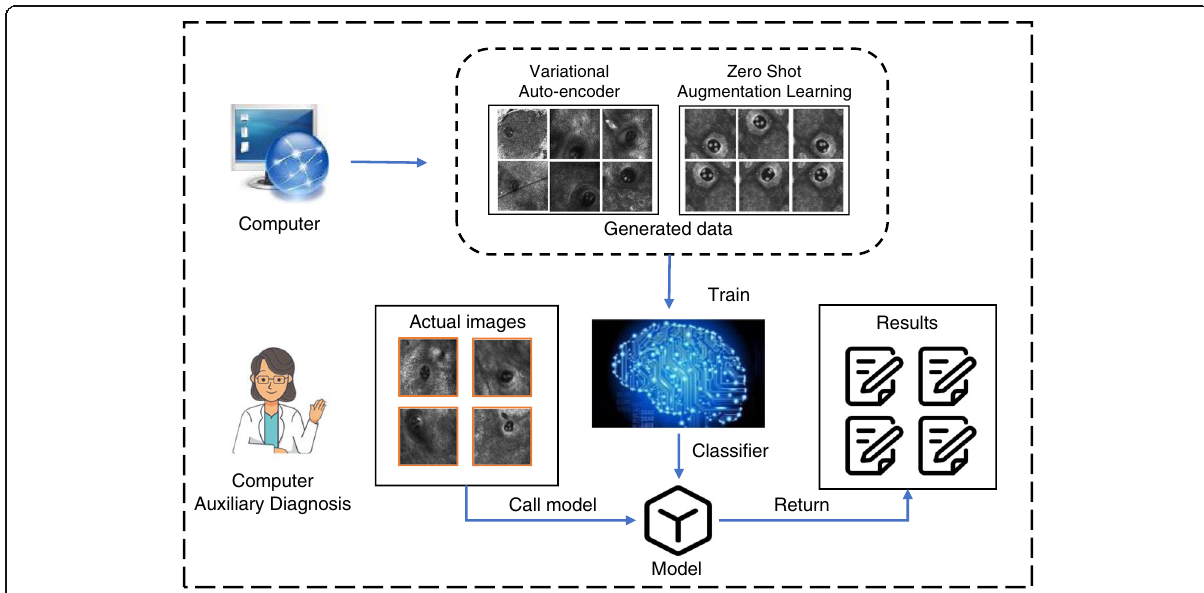
Fig. 3 Auxiliary diagnosis model acquisition process. The specific workflow of the method includes four steps: collecting medical image data sets from the hospital; in the small sample method, inputting the seed data set into the designed variational auto-encoder to generate the image, and in the zero sample method, using ZASL to generate medical image data set; using the extended data set from the previous step to train deep neural network to obtain medical auxiliary diagnosis model; and using the trained medical auxiliary diagnosis model to test the test set to evaluate the model